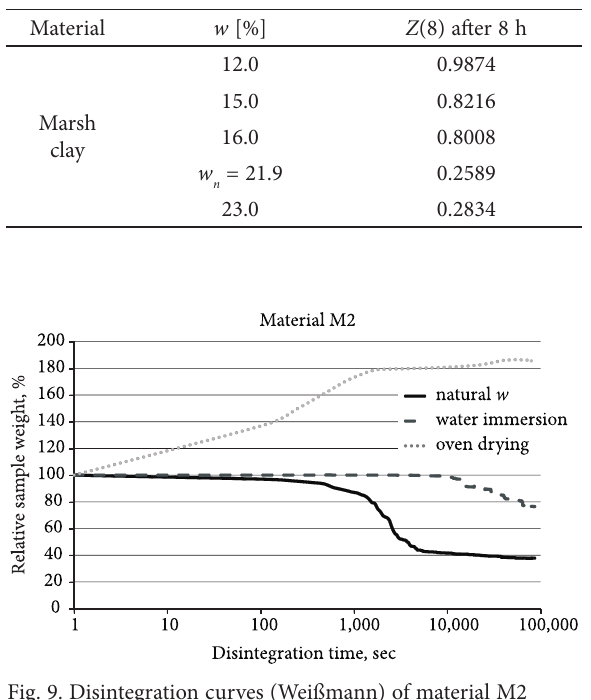
Table 9. Disintegration time t Material